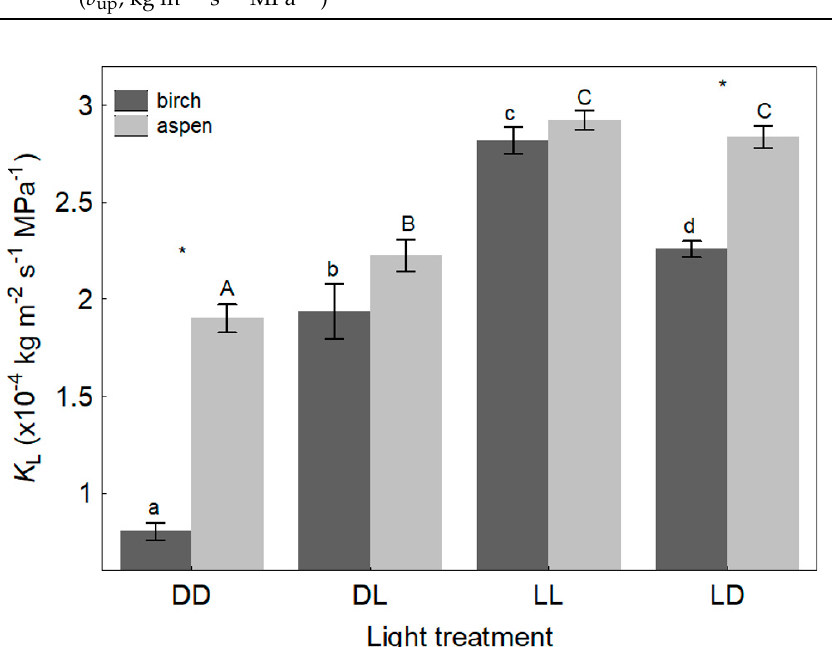
Figure 1. Mean values ( ± SE) of leaf hydraulic conductance ( K L ) depending on species and light treatment. DD—initial dark conditions; DL—initial light conditions (exposure to light for less than 1 h); LL—light conditions (exposure to PPFD 900–1000 µ mol m − 2 s − 1 for 1–5 h); LD—final